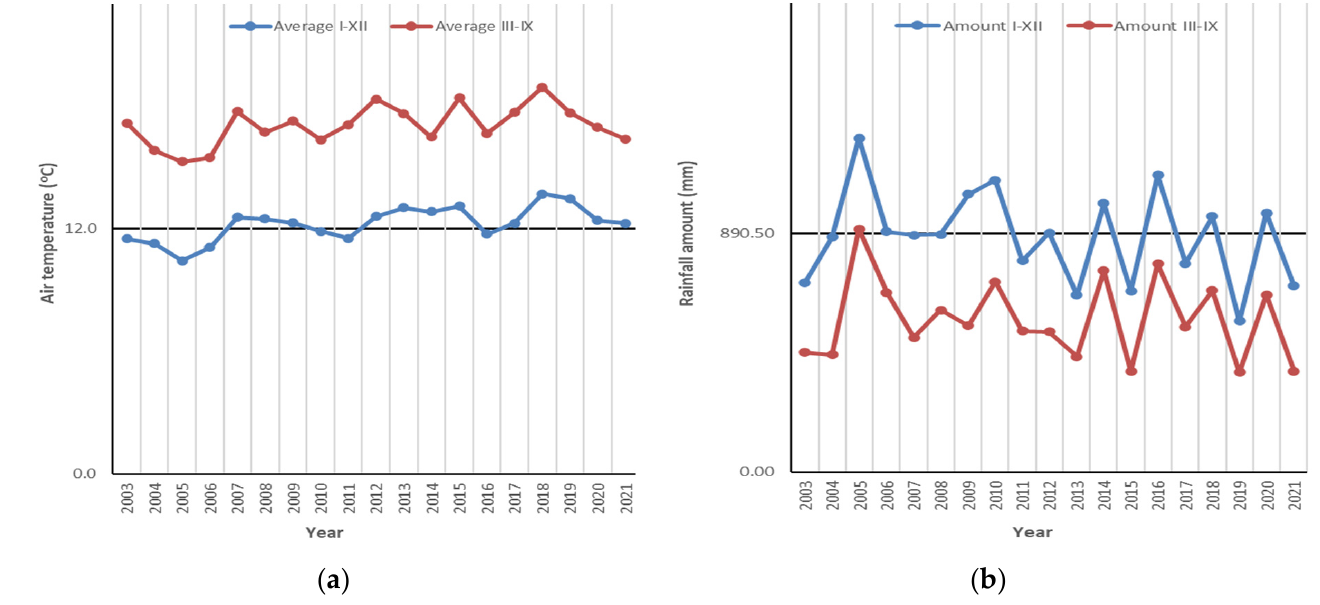
Figure 1. Climate data from the nearest meteorological station (Oravi ț a, Cara ș -Severin County) during 2003–2021 time interval (average value during the experiment displayed): ( a ) air temperature (°C); ( b ) rainfall amount (mm) (Source data: Oravi ț a Meteorological Station).